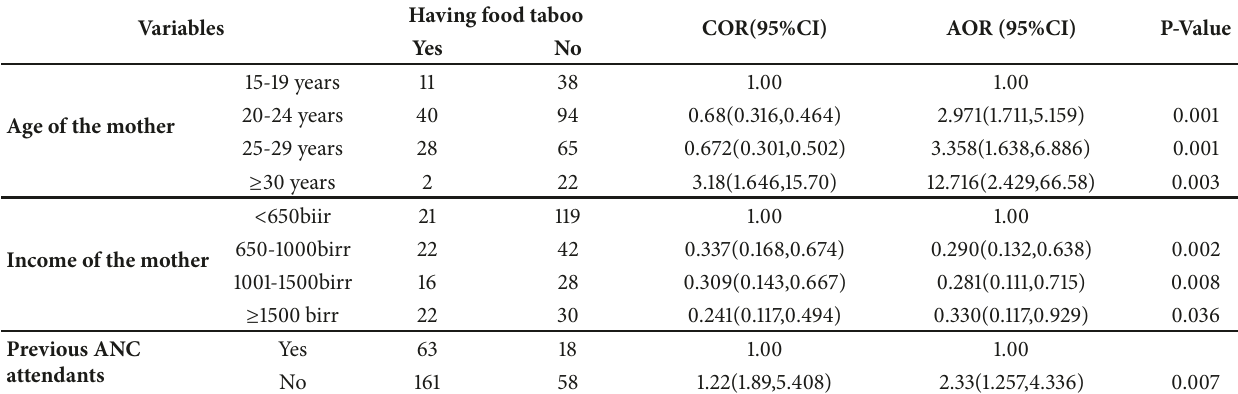
Table 2: Determinants of food taboo in public health institution in Awabel district, Northwest Ethiopia, April 15-May 17, 2016 (n=307).